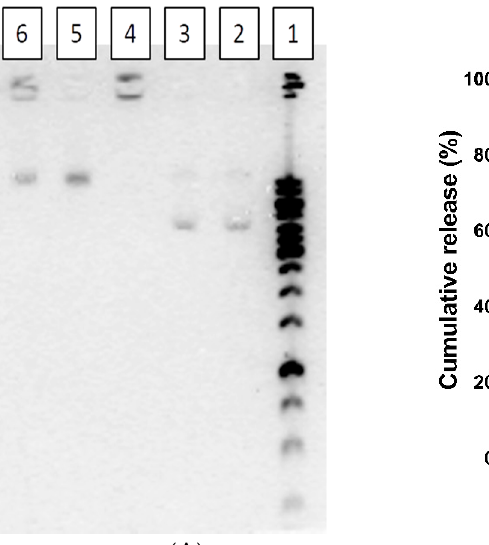
after 30 min exposure to 5W UV 365 nm LED lamp. ( B ) Release of Cy3-oligo-dT-dA from IPECs (non- cross-linked, cross-linked without further treatment and cross-linked with subsequent 30 min exposure to 5W UV 365 nm LED lamp) evaluated via measurement of fluorescence of filtrate after